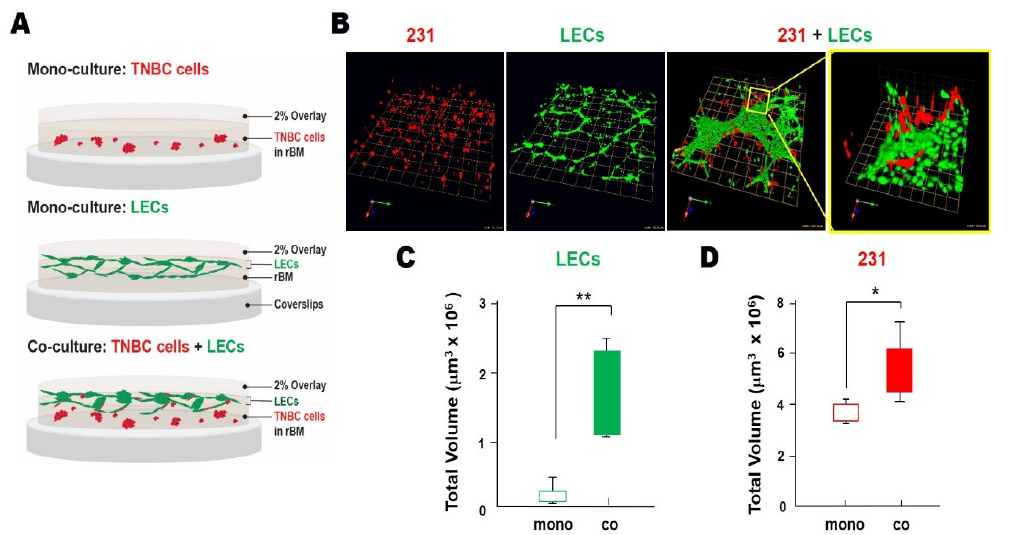
Figure 2. Increases in volumes of LEC networks and spheroids formed by the MDA-MB-231 TNBC cell line were observed when the two cell types were grown for 4 days in direct 3D coculture. ( A ) Schematics of monocultures and cocultures. ( B ) Representative images of 3D reconstructions of monocultures of 231s or LECs and 231:LEC MG cocultures. Images are tiled from 16 contiguous fields; each grid represents 243 μ m. Enlarged image on the right illustrates interactions between TNBC spheroids and LEC networks in greater detail; each grid represents 60 μ m. ( C , D ) Total LEC and 231 volumes when grown alone (mono) or in direct coculture (co) were quantified with Volocity ( n = 3). * p ≤ 0.05 and ** p ≤ 0.01.